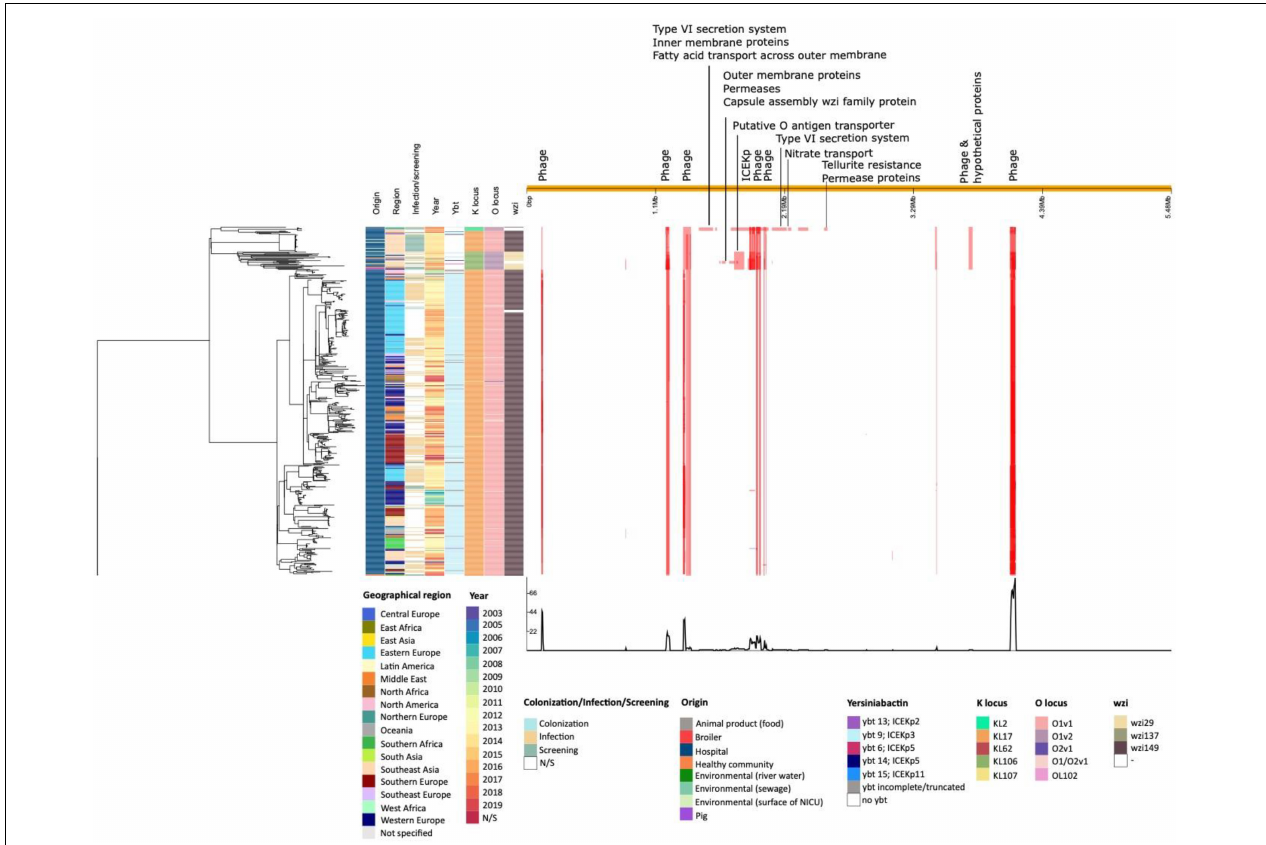
FIGURE 6 | Phylogenetic analysis of an international collection of hospital-associated, animal-associated, community-associated (healthy individuals), food-associated, and environmental K. pneumoniae ST101. A maximum likelihood phylogeny was generated from whole genome alignment of 596 K. pneumoniae ST101 using the Gubbins algorithm. The right panel shows the pattern of predicted recombinations. Red bars show polymorphic sites suggesting horizontal sequence transfer. Each row relates to an isolate in the phylogeny and each column represents a base in the reference genome